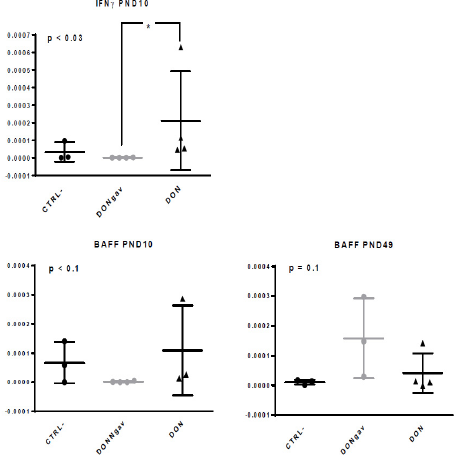
Figure 7. Sow diet mycotoxin contamination (DON) and neonate mycotoxin gavage (DONgav) modified jej ‐ LP cell numbers and the proportion of resident APC. Datasets were analyzed with the non ‐ parametric Kruskal ‐ Wallis test followed by Dunn’s multiple comparison tests when appropriate for each age. ( A ) Numeration of immune mononuclear cells (× 10 6 per g of tissue) isolated from jej ‐ LP at PND10, PND21 and PND49 from CTRL ‐ ( n = 4, empty black bar), DONgav ( n = 4, light grey bar) and DON ( n = 4, dark grey bar) piglets (# p < 0.10). ( B ) CD16+ MHCII+ proportion (% of total immune cells) in jej ‐ LP CTRL ‐ ( n = 4, empty black bar), DONgav ( n = 4, light grey bar), and DON ( n = 4, dark grey bar) explants (* p < 0.02). ( C ) CD11R1+ MHCII+ proportion (% of total immune cells) in jej ‐ LP CTRL ‐ ( n = 4, empty black bar), DONgav ( n = 4, light grey bar) and DON ( n = 4, dark grey bar).